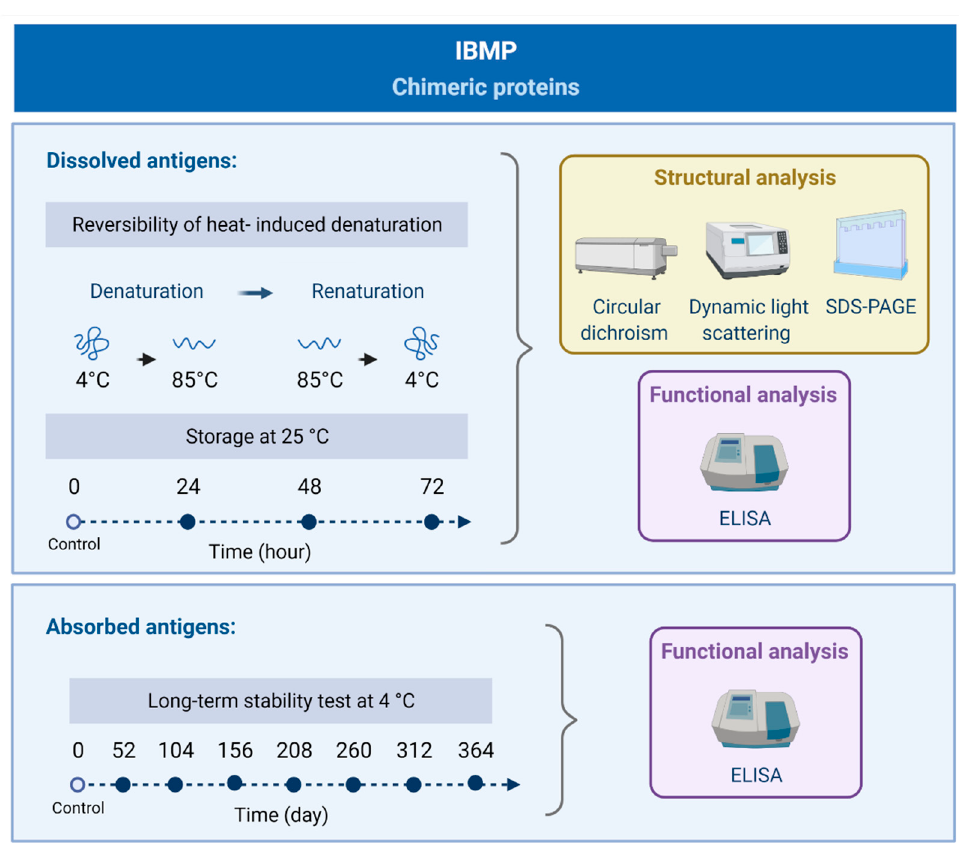
Figure 1. Flowchart of the study design for evaluating the stability of dissolved and absorbed IBMP chimeric proteins by using functional (ELISA) and structural (CD, DLS, SDS-PAGE) analysis. Table 1. Constitution of the IBMP chimeric recombinant